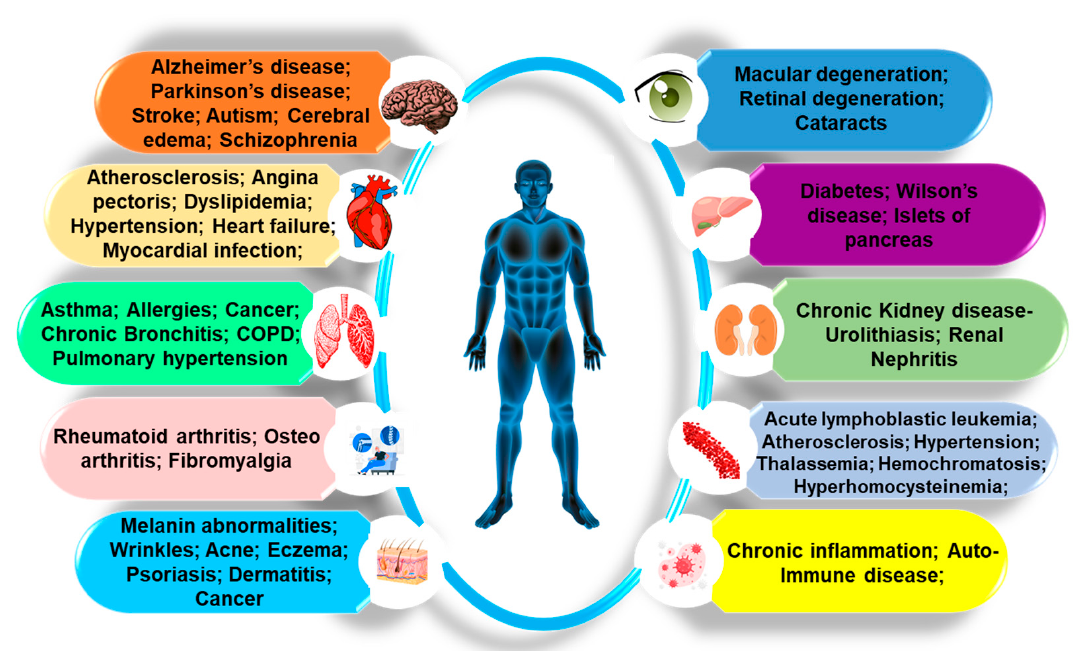
Figure 2. The overall negative impacts of mNPs on the human body. mNPs are oxidants that typically induce oxidative damage. mNPs can drive redox processes, resulting in endogenous ROS generation and significant health risks such as mutagenicity. (Image sources: skin anatomy, blood cells flow images by macrovector on Freepik; liver image by Freepik; arthritis image and infection image by Storyset on Freepik; human body image from brgfx on Freepik; the other images were downloaded from Pixabay). COPD—chronic obstructive pulmonary